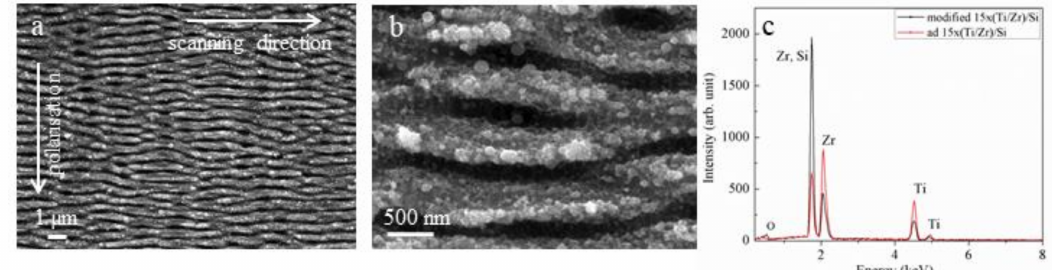
Figure 1. SEM images ( a , b ) of laser-modified 15 × (Ti / Zr) / Si multilayer thin films with a fluence of 0.662 Jcm − 2 , and energy-dispersive X-ray spectroscopy (EDS) spectra ( c ) recorded from un-modified and laser-treated